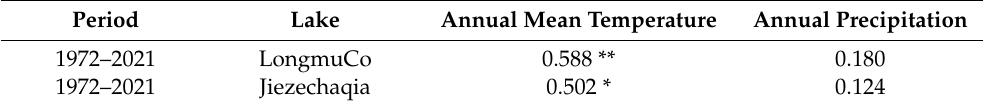
Table 2. Pearson’s correlation coefficients for lake area and climate